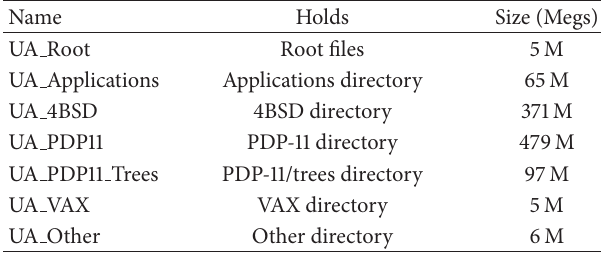
Figure 4: Example of dangling headings.